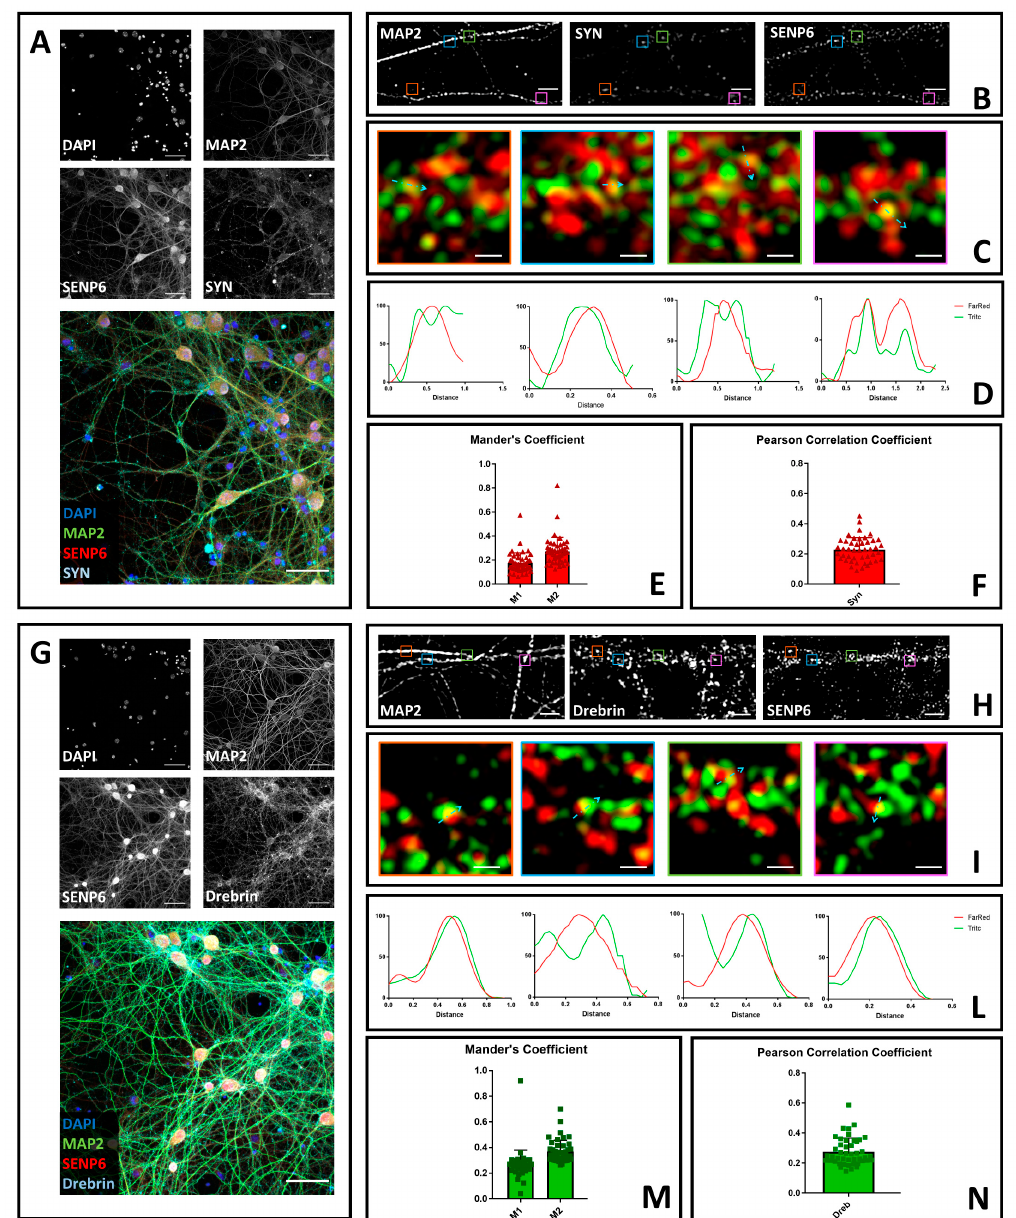
Figure 2. Confocal and SIM microscopy to determine the neuronal localization of SENP1. ( A ) Neurons were fixed and stained with anti-SENP6 (red), anti-synaptophysin (light blue), and anti-Map2 (green). Images were obtained using a Nikon N-SIM confocal microscope and overlaid to assess protein localization. Nuclei were stained with Hoechst. Scale bar of 50 μ m. ( B ) 3D-SIM images acquired with a 100× objective. Scale bar of 2 μ m. Squares represent the location of the inset present in panel C. ( C ) Merge images of reconstructed 3D-SIM images of SENP6 (green) and synaptophysin (red). Scale bar of 0.5 μ m. ( D ) Intensity profile (green for SENP6 and red for synaptophysin) representing the values indicated by the light blue arrow in panel C. The values were normalized to 100 (arbitrary unit). ( E ) Mander’s coefficients of SENP6 co-localization with synaptophysin (M1) and synaptophysin co-localization with SENP6 (M2). ( F ) Pearson’s Correlation Coefficient of SENP1 and synaptophysin (SYN). Data are the mean ± SD of 45 fields from three independent experiments. ( G ) Neurons were fixed and stained with anti-SENP6 (red), anti-drebrin (light blue), and anti-Map2 (green). Images were obtained using a Nikon N-SIM confocal microscope and overlaid to assess protein localization. Nuclei were stained with Hoechst. Scale bar of 50 μ m. ( H ) 3D-SIM images acquired with a 100× objective. Scale bar of 2 μ m. Squares represent the location of the inset present in panel C. ( I ) Merge images of reconstructed 3D-SIM images of SENP6 (green) and drebrin (red). Scale bar of 0.5 μ m. ( J ) Intensity